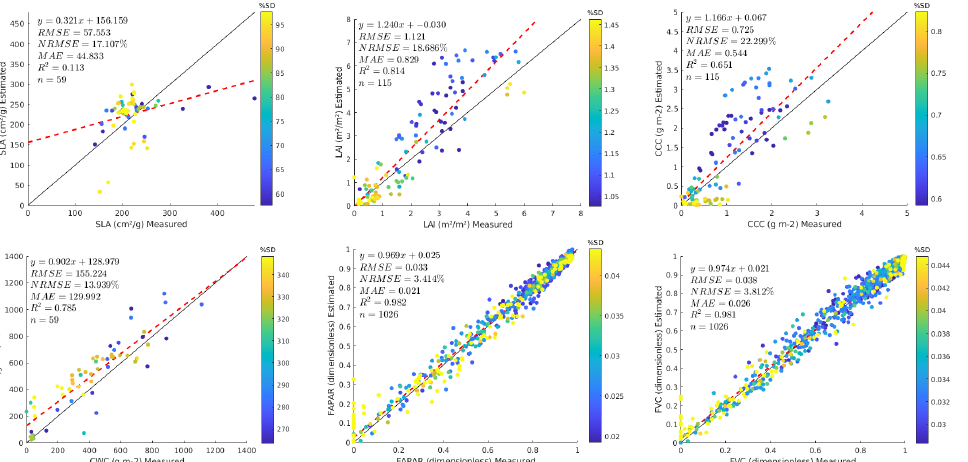
Figure 5. Scatter plots displaying the GPR-20PCA model results against the Grosseto and MNI in situ measurements, with goodness-of-fit statistics. In the case of FAPAR and FVC, theoretical results are provided. The colors of points represent the standard deviation (SD) obtained by the GPR models.